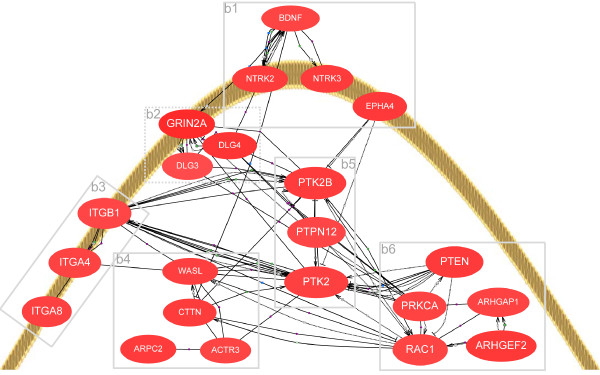
Network of genes for neuritogenesis and neurite elongation. A neurite growth cone and genes related to neuritogenesis and neurite elongation are shown. These genes are grouped on the basis of their functions and these gene groups are marked by dotted-line boxes. The function groups in these boxes are: b1 - growth factor and ephrin receptors; b2 - Glu receptor and scaffolding genes; b3 - extracellular matrix interacting genes; b4 - actin-organizing genes; b5 - focal adhesion complex genes; and b6 - signal transduction (kinase, phosphatase, small GTPase-binding and activating) genes. The lines between genes indicate their interactions based on previously published experimental data (multiple interaction types, such as activation, inhibition, binding, etc., exist in the network). All genes in this network were up-regulated in the Glud1 neurons, indicative of neuronal efforts to re-grow neurites in response to neurite loss observed in Tg mouse neurons. PTK2B, a major focal adhesion kinase, is a hub node in this network, indicating that it is one of the key gene players in neuritogenesis and neurite elongation.